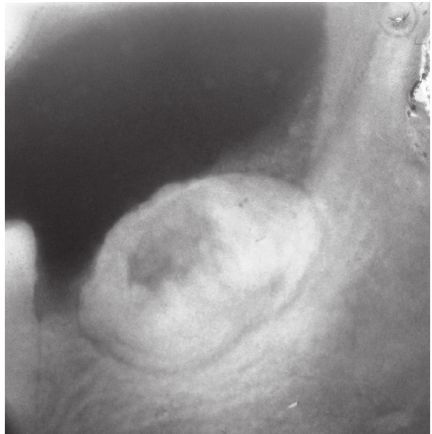
Figure 1: Radiographic image of the odontoma.